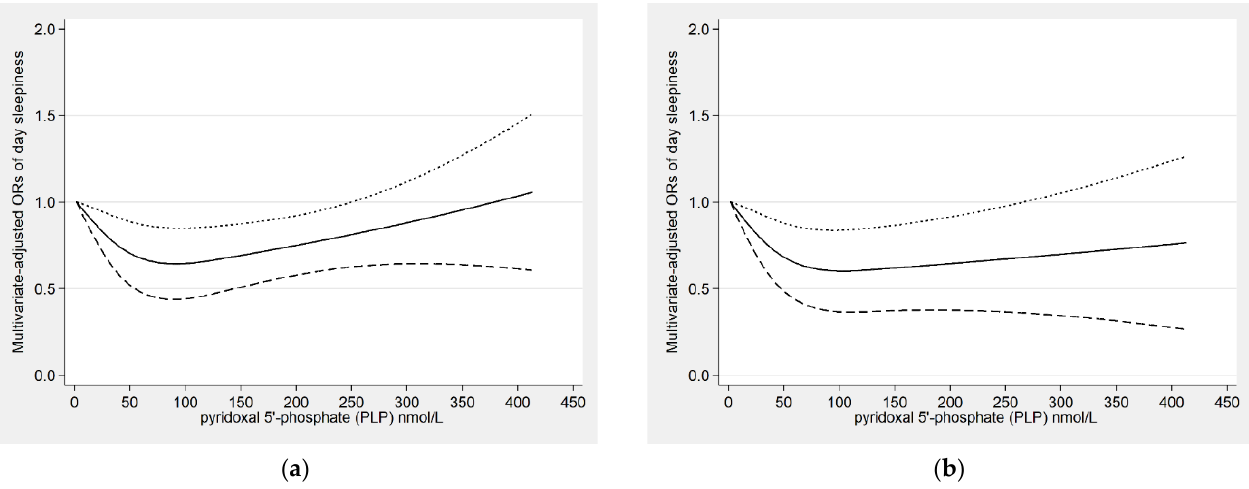
Figure 2. Restricted cubic spline model of the odds ratios (ORs) of day sleepiness with pyridoxal 5 ′ -phosphate (PLP) concentration for the overall population ( a ) and males ( b ). The solid line and dashed lines represent the estimated ORs and the 95% confidence intervals.